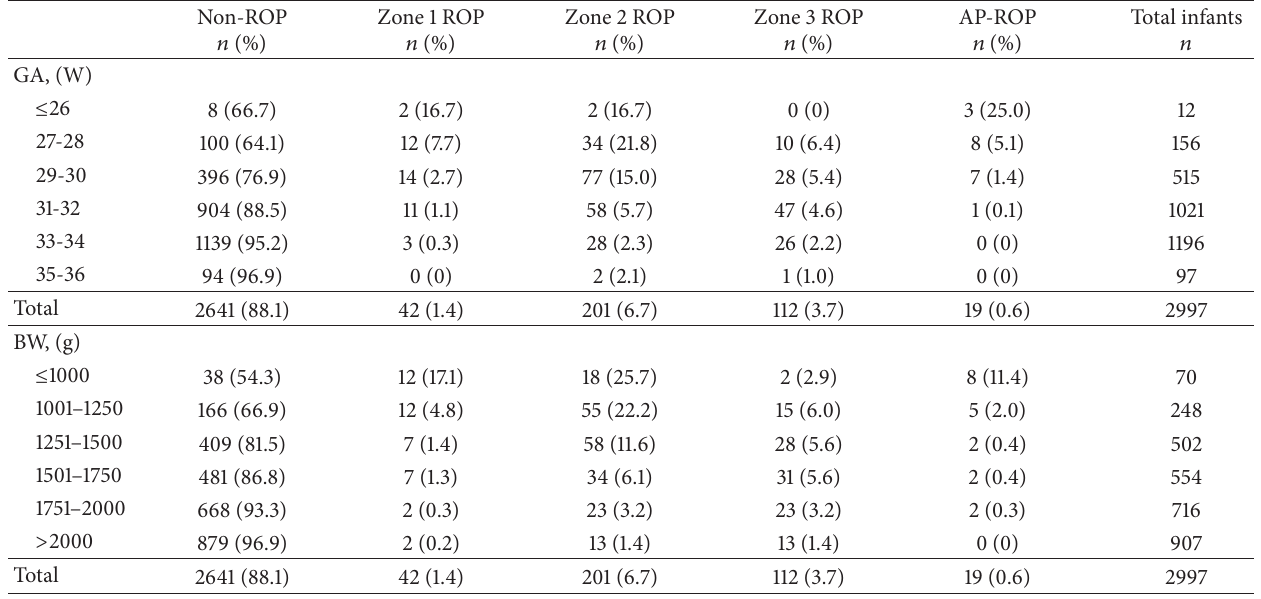
Table 3: The incidence rate of ROP with different zones according to gestational age and birth weight.